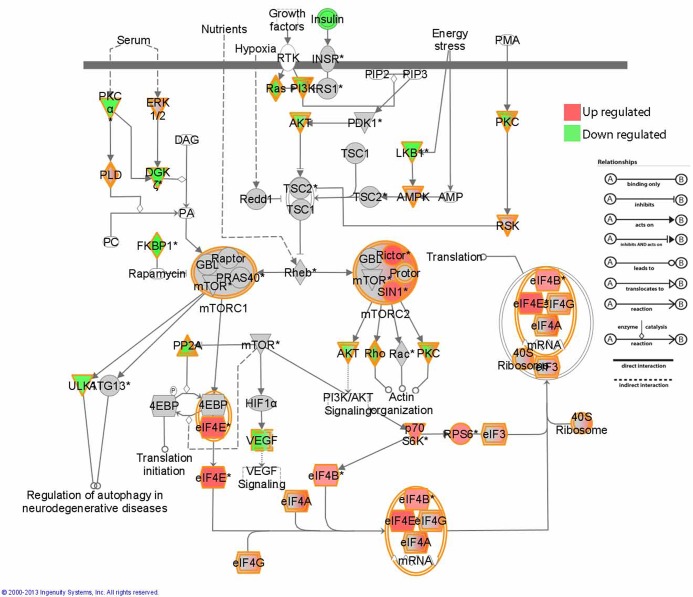
Alterations in elements of mTOR, EIF2 and EIF4 signaling pathways in Braak alpha-synuclein 1 and 2 compared to controls.Image generated using Ingenuity pathway analysis (IPA).